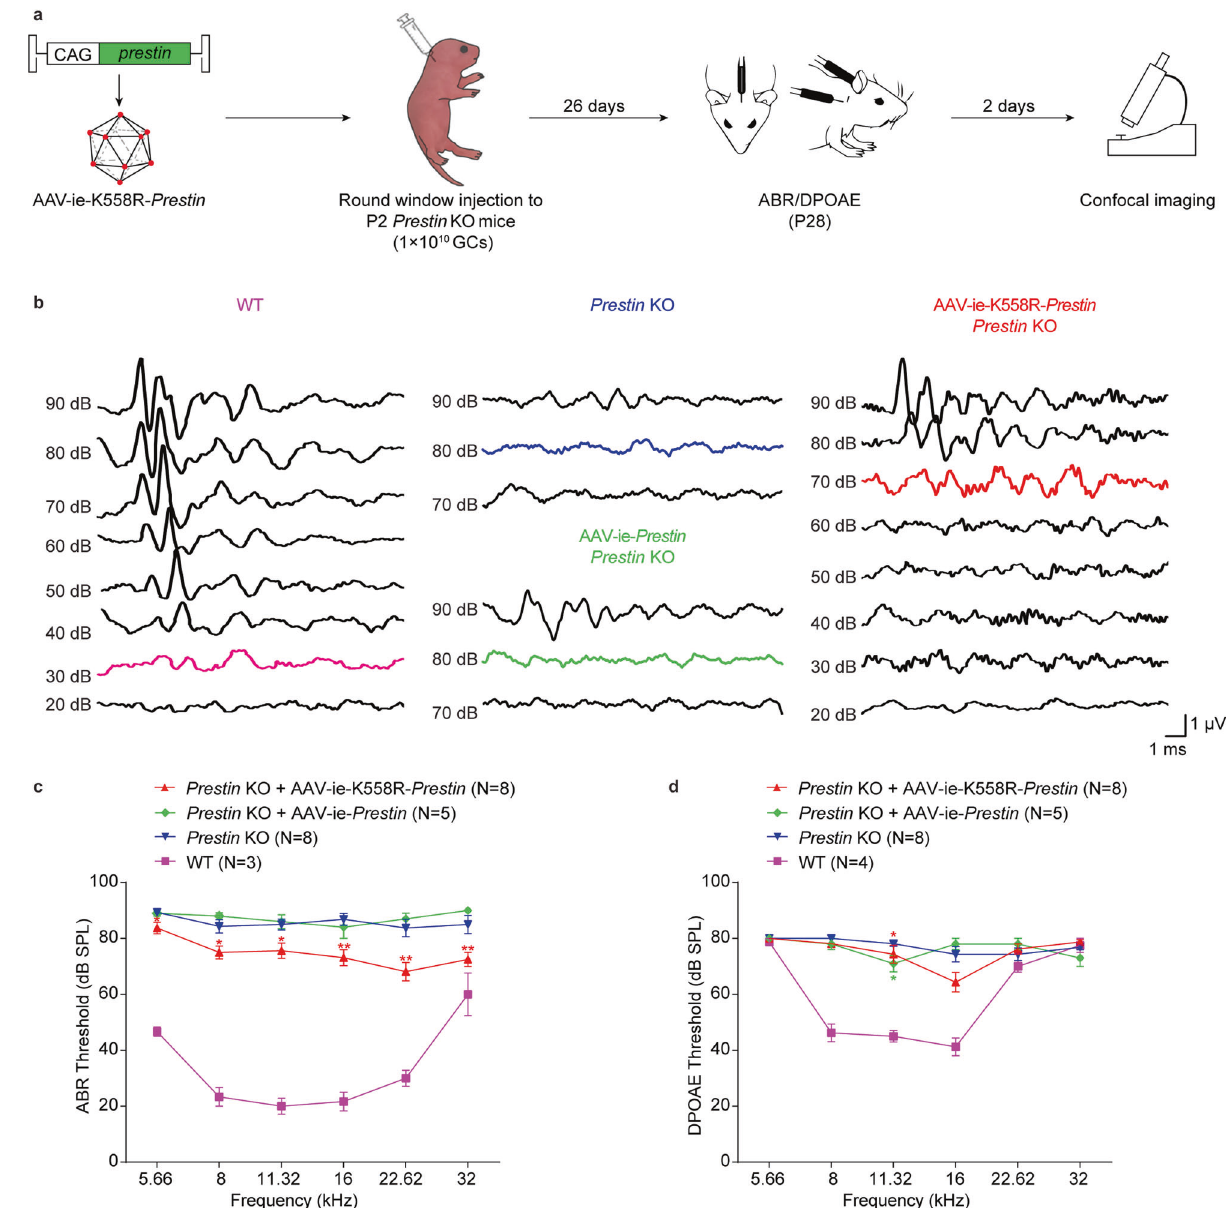
Fig. 3 AAV-ie-K558R- Prestin restores auditory function of Prestin KO mice. a Schematic of Prestin KO mice hearing recovery experiments. AAV-ie and AAV-ie-K558R vectors were used to package a single strand genome that expresses Prestin driven by the CAG promoter. b Families of ABR waveforms recorded at P28 from uninjected WT mouse, Prestin KO mouse without treatment and Prestin KO mouse injected with AAV-ie- Prestin or AAV-ie-K558R- Prestin . ABRs were recorded using 16 kHz tone bursts at increasing sound pressure levels in 10 dB steps. Thresholds were determined by the presence of Peak 1 and are indicated by colored traces. Scale bar applies to all families. c , d ABR and DPOAE thresholds plotted as a function of stimulus frequencies for Prestin KO mice injected with AAV-ie- Prestin (green) or AAV-ie-K558R- Prestin (red). Uninjected contralateral ear of Prestin KO mice were used for negative control (blue) and uninjected WT mice were used as positive control (purple). Data were shown as Mean ± SEM. Signi fi cance (* P < 0.05, ** P < 0.01, *** P < 0.001) was calculated using multiple t test between AAV-injected group and contralateral uninjected group brief, phosphorylation sites in AAV-ie capsid were predicted puri fi ed virus. The genome-containing titers of AAVs were determined with NetPhosK (http://www.cbs.dtu.dk/services/NetPhosK), by SYBR (Roche) analysis using primers targeting the WPRE region. Phosida (Phosphorylation Site Database; http://www.phosida. The qPCR primers for WPRE are listed as follows: forward, 5 ′ - com), KinasePhos (http://kinasephos.mbc.nctu.edu.tw), and GTCAGGCAACGTGGCGTGGTGTG-3 ′ ; reverse, 5 ′ -GGCGATGAGTTCC Scansite (http://scansite.mit.edu). Ubiquitination sites were GCCGTGGC-3 ′ . predicted with UbiPred (http://iclab.life.nctu.edu.tw/ubipred/) prediction servers. Structure analysis of AAV-ie capsid For amino acid phosphorylation and ubiquitination site prediction, we followed a previously published method. 43 In Signal Transduction and Targeted Therapy (2022)